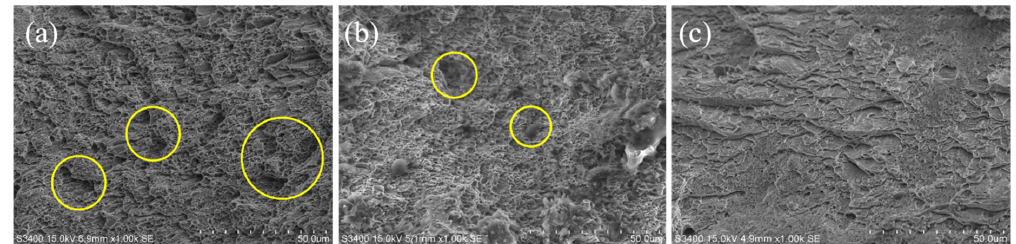
Figure 13. SEM images of tensile specimens under different hydrogen charging time: ( a ) Without hydrogen charging; ( b ) Hydrogen charging for 24 h; ( c ) Hydrogen charging for 48 h.